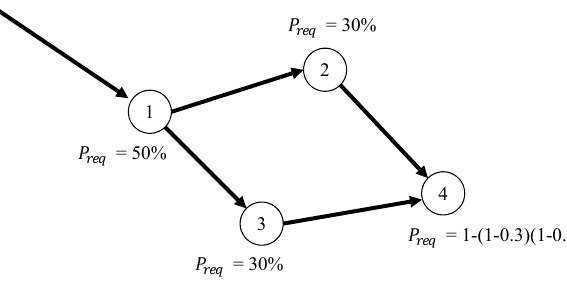
Figure 4. An example of the path merger